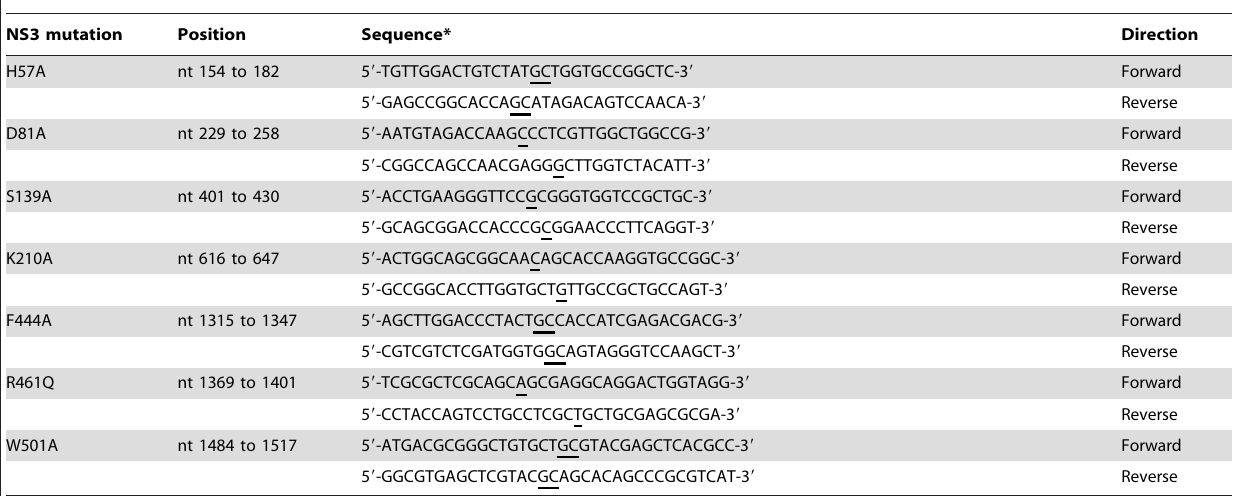
*The mutated residues in the primer sequences are underlined; nt, nucleotide.